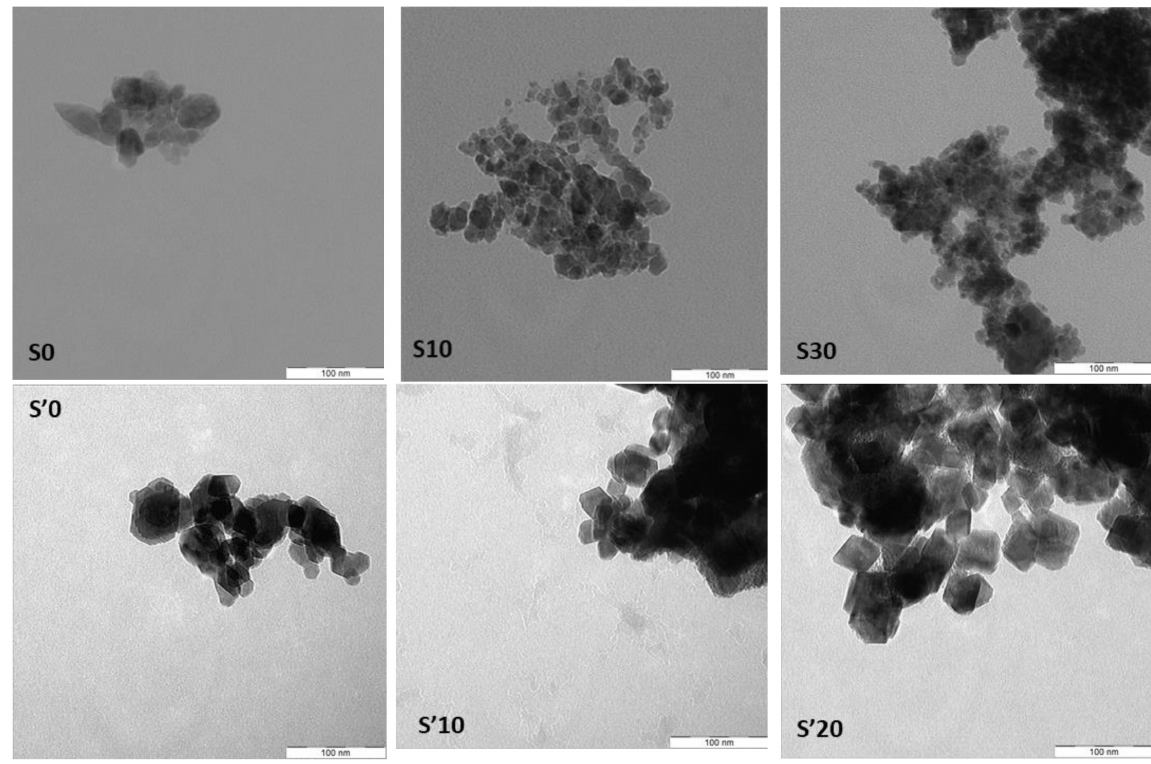
Figure 11. Transmission electron microscopy (TEM) images of the decomposition products S0, S10, S30 and S’0, S’10,